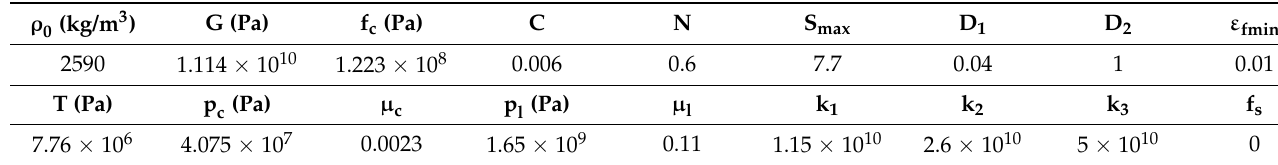
Table 2. HJC material model parameters of gangue.